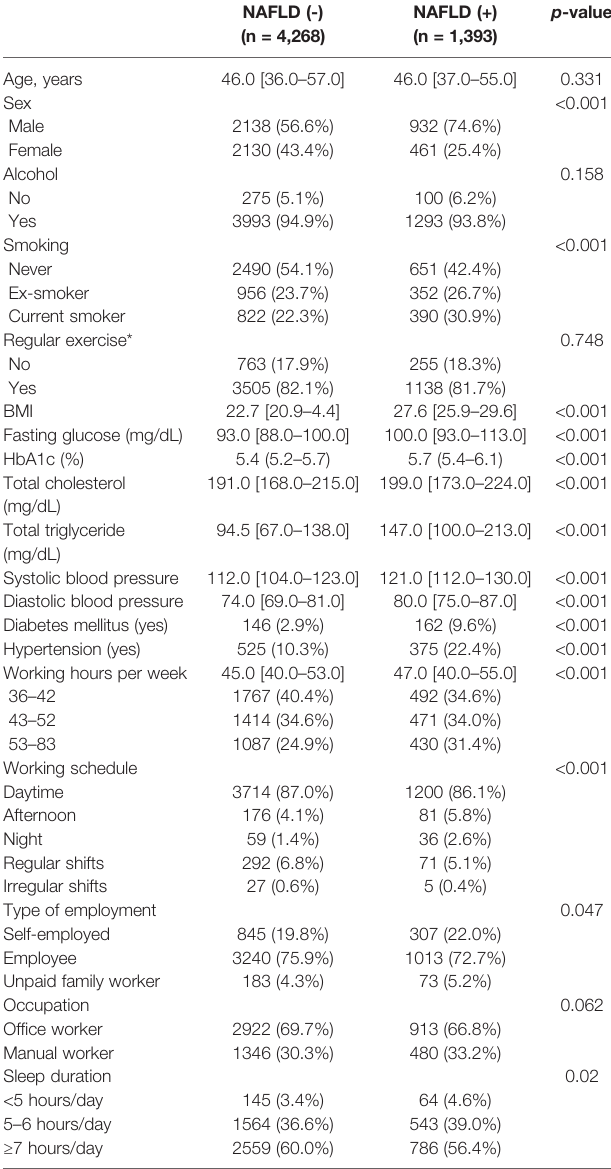
BMI, body mass index. *Regularexercisewasde fi nedaseitherwalkingorweighttrainingformorethantwodaysa week on